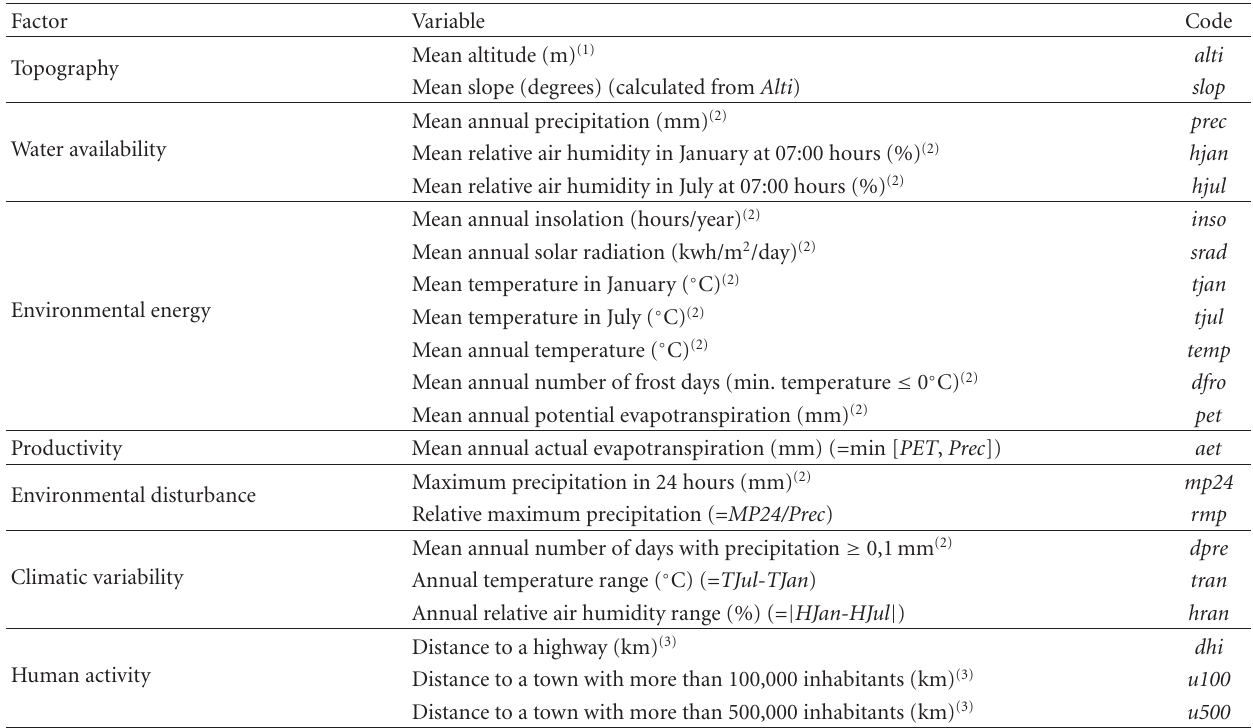
Table 1: Factors and their related variables used to model the distributions of Bufo bufo , Epidalea calamita , and the combined presences of the two species. Sources: (1) U. S. Geological Survey (1996); (2) Font (1983, 2000); (3) I.G.N. (1999); data on the number of inhabitants of urban centres taken from Enciclop´edia Universal (http://www.universal.pt) for Portugal and from the Instituto Nacional de Estad´ıstica